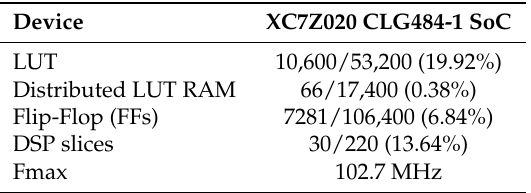
Figure 11. Convergence behavior of channel mismatches with the proposed technique on the FPGA hardware implementation: ( a ) offset, ( b ) gain, and ( c ) timing. Table 1. FPGA implementation